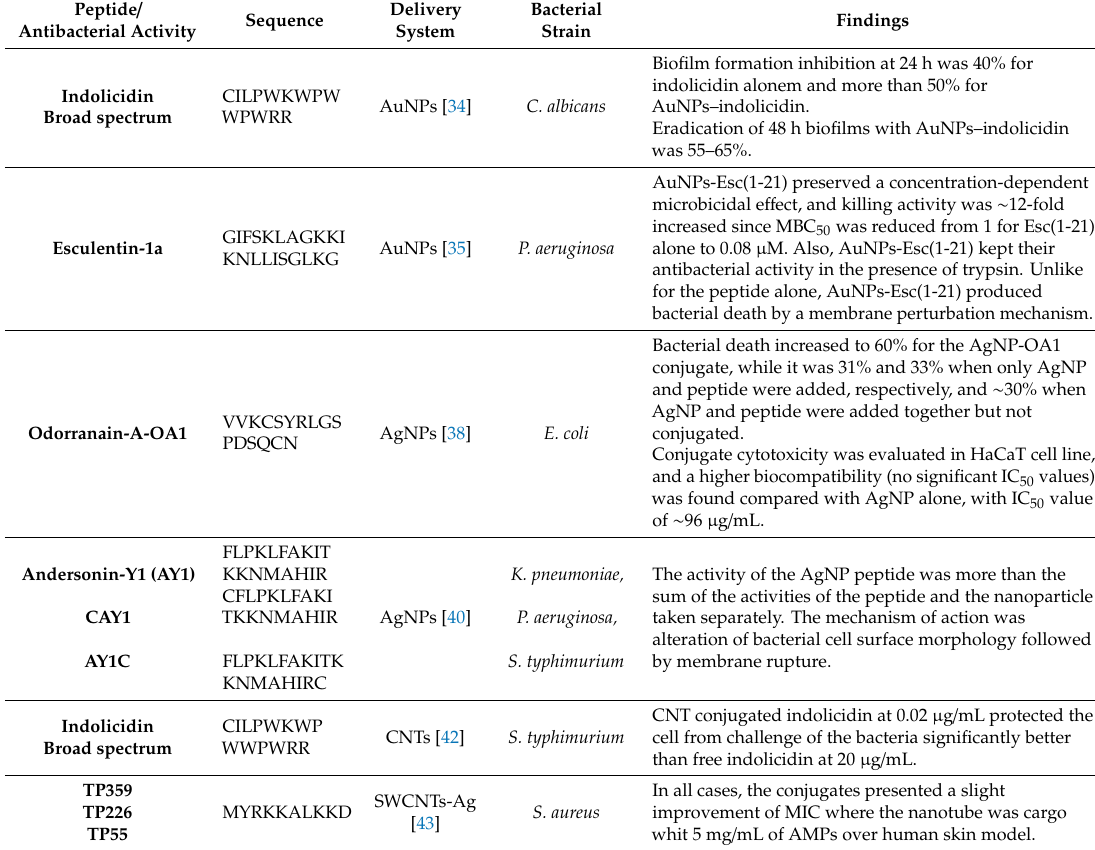
Table 2. Overview of the di ff erent inorganic nanosystems as delivery systems for